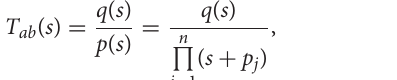
FIGURE 2 | Magnitude of the transfer functions T an to populations a vs. frequency, as labeled, for k